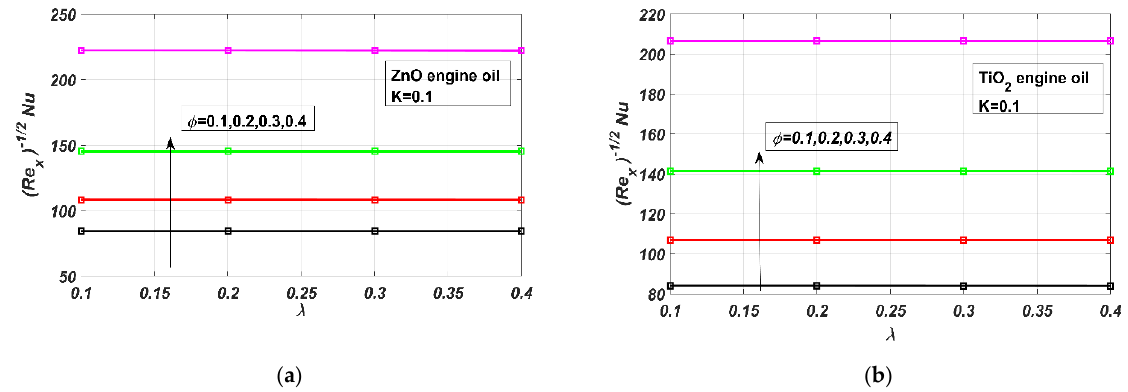
Figure 7. The impact of rotation parameter λ ( a , b ) on skin friction along the y -axis.